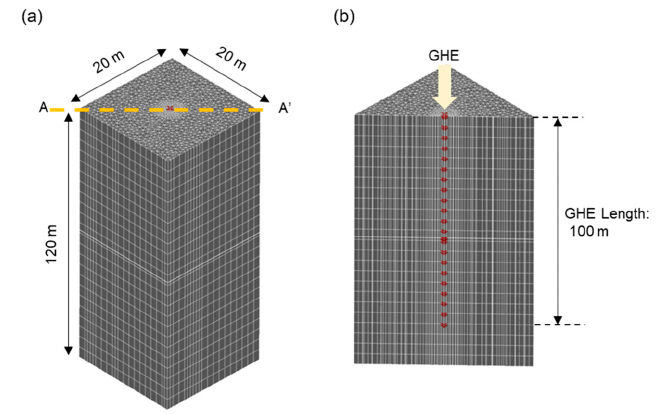
Figure 3. Ground heat exchanger (GHE) model. ( a ) Bird’s-eye view ( b ) cross-sectional view at